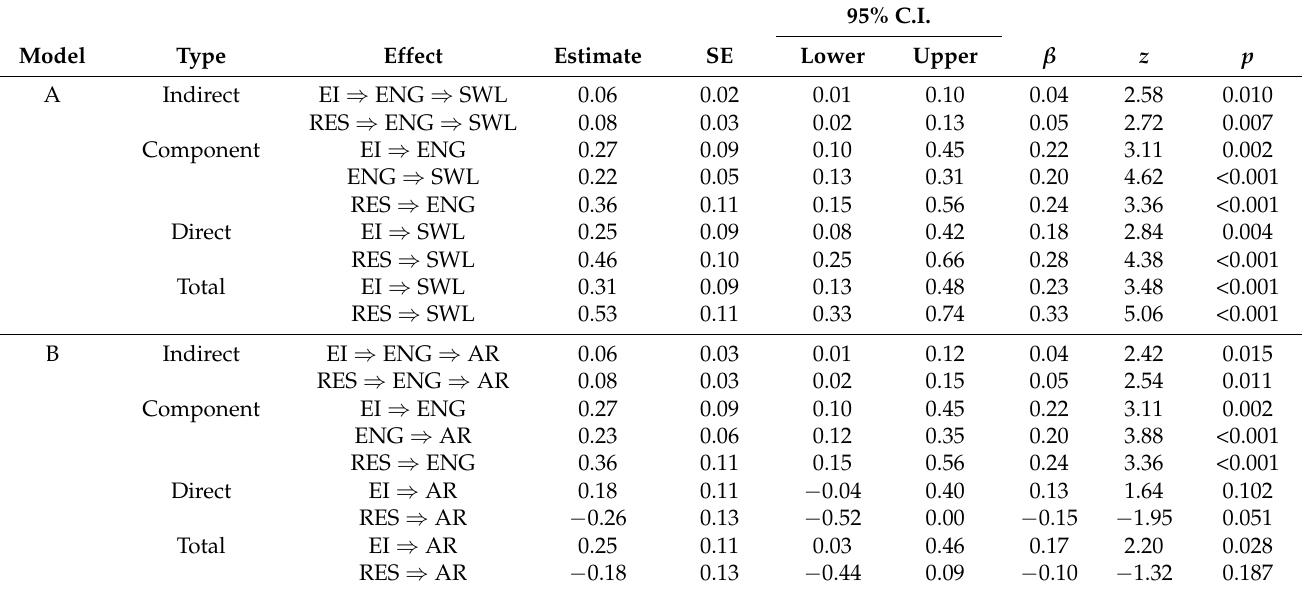
Table 2. Indirect and Total Effects in Mediational